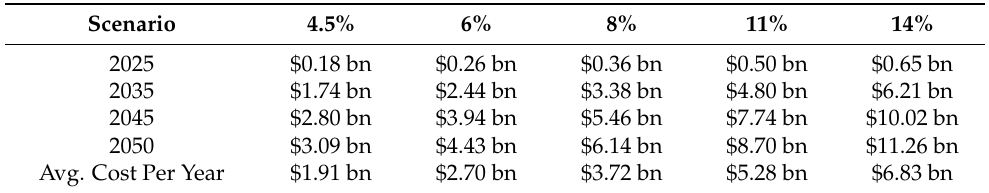
Table 5. Avoided coal cost per year based on coal price forecast and quantity expected to be avoided according to each scenario for 2025, 2035, 2045, and